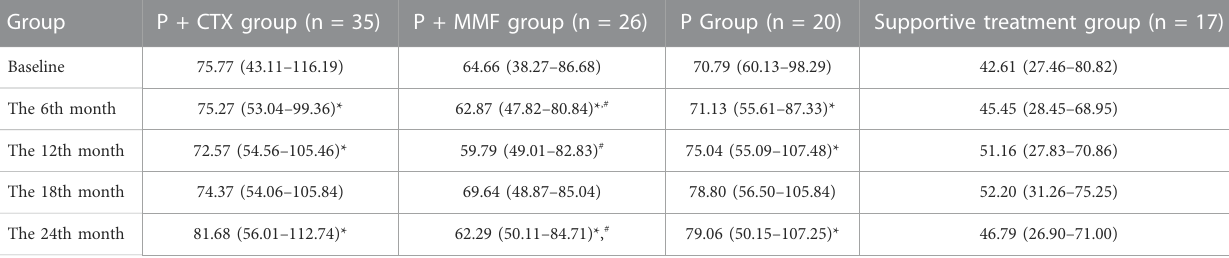
TABLE 5 Comparison of eGFR in different treatment groups of severe IgAN.